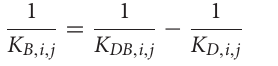
steps 2–3, capacity curves of F, DB, and BF systems are known and plotted together with the design Acceleration Displacement Response Spectrum (ADRS), i.e., they reduced by the equivalent damping ratio ( Figure 3 ). In this section, the ADRS curve is defined with reference to the Italian design NTC code (Ministry of Infrastructures, 2018). However, any response spectrum according to international codes can be uploaded by defining equivalent parameters.